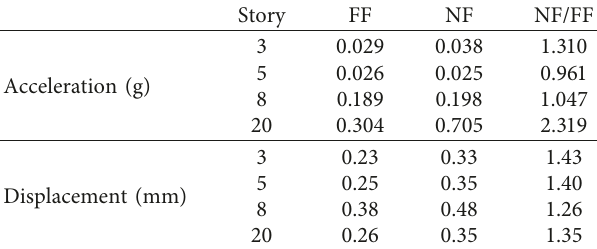
Table 4: Comparison of the average value of the peak floor am- plification of stories and roof displacement subjected to near- and far-field earthquakes.